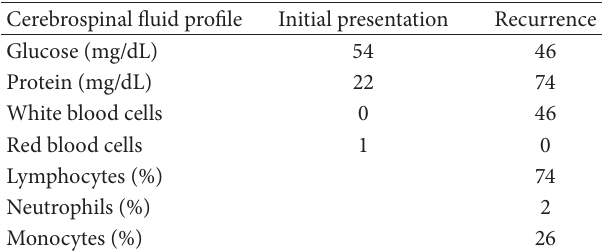
Table 1: Laboratory findings at initial presentation and recurrence of Guillain-Barre